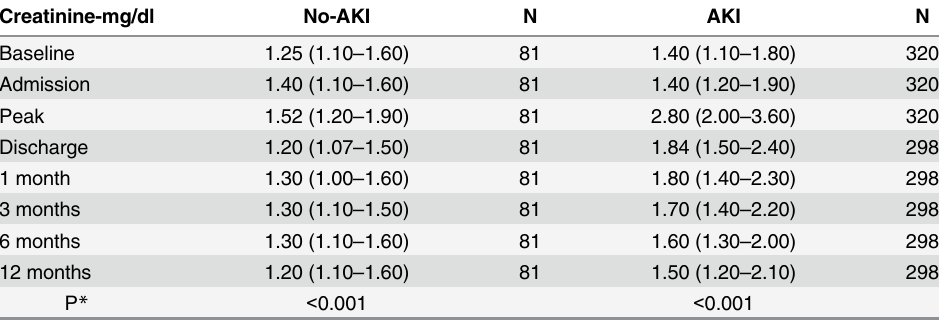
Table 6. Creatinine evaluation in patients with and without AKI according to the KDIGO.